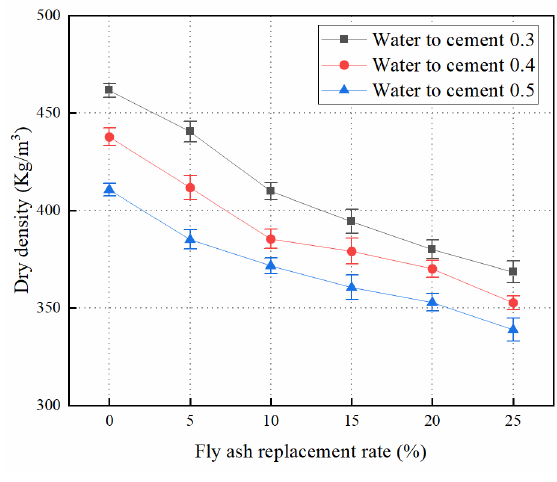
Figure 7. The density of foam concrete with different matching ratios.